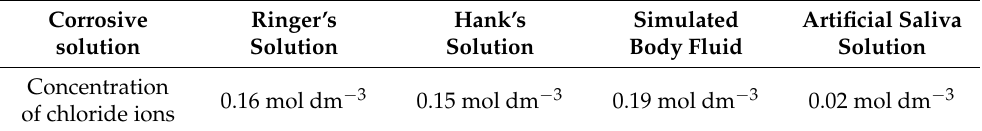
Table 2. Chloride ion concentration in individual simulated body fluids. Corrosive solution Ringer’s Solution Hank’s Solution